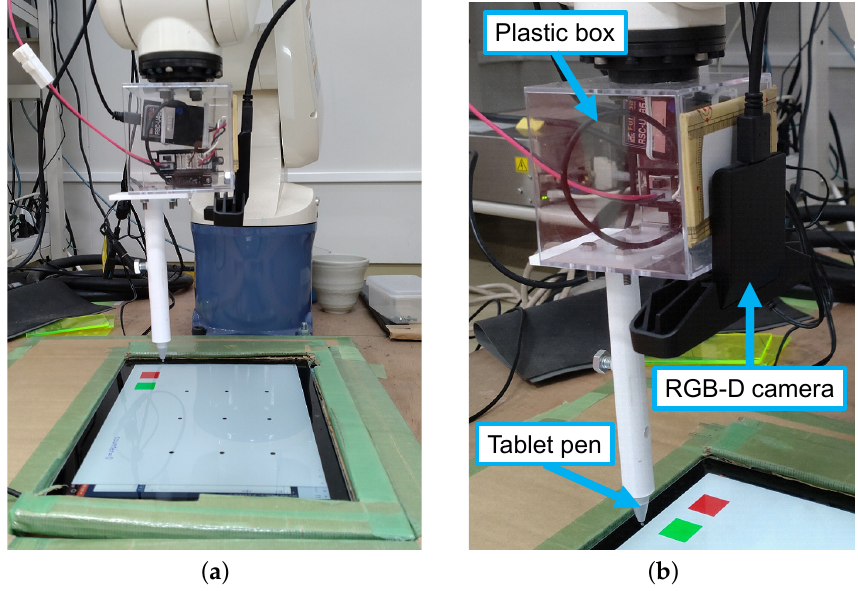
Figure 1. ( a ) Appearance of the developed system; ( b ) details of the